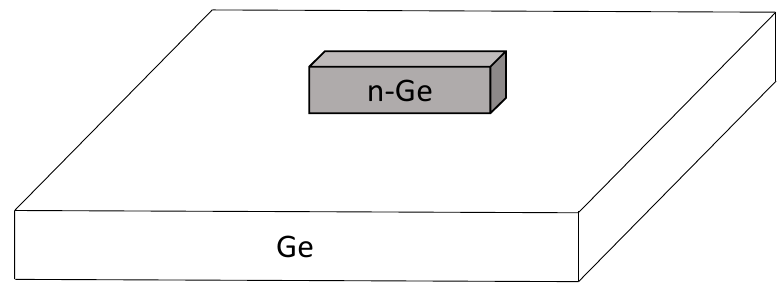
Figure 2. Depiction of the model used for the finite difference time domain (FDTD) calculations. Here, a phosphorous doped, n-type germanium (n-Ge) rectangular particle on top of a germanium (Ge) substrate is shown.